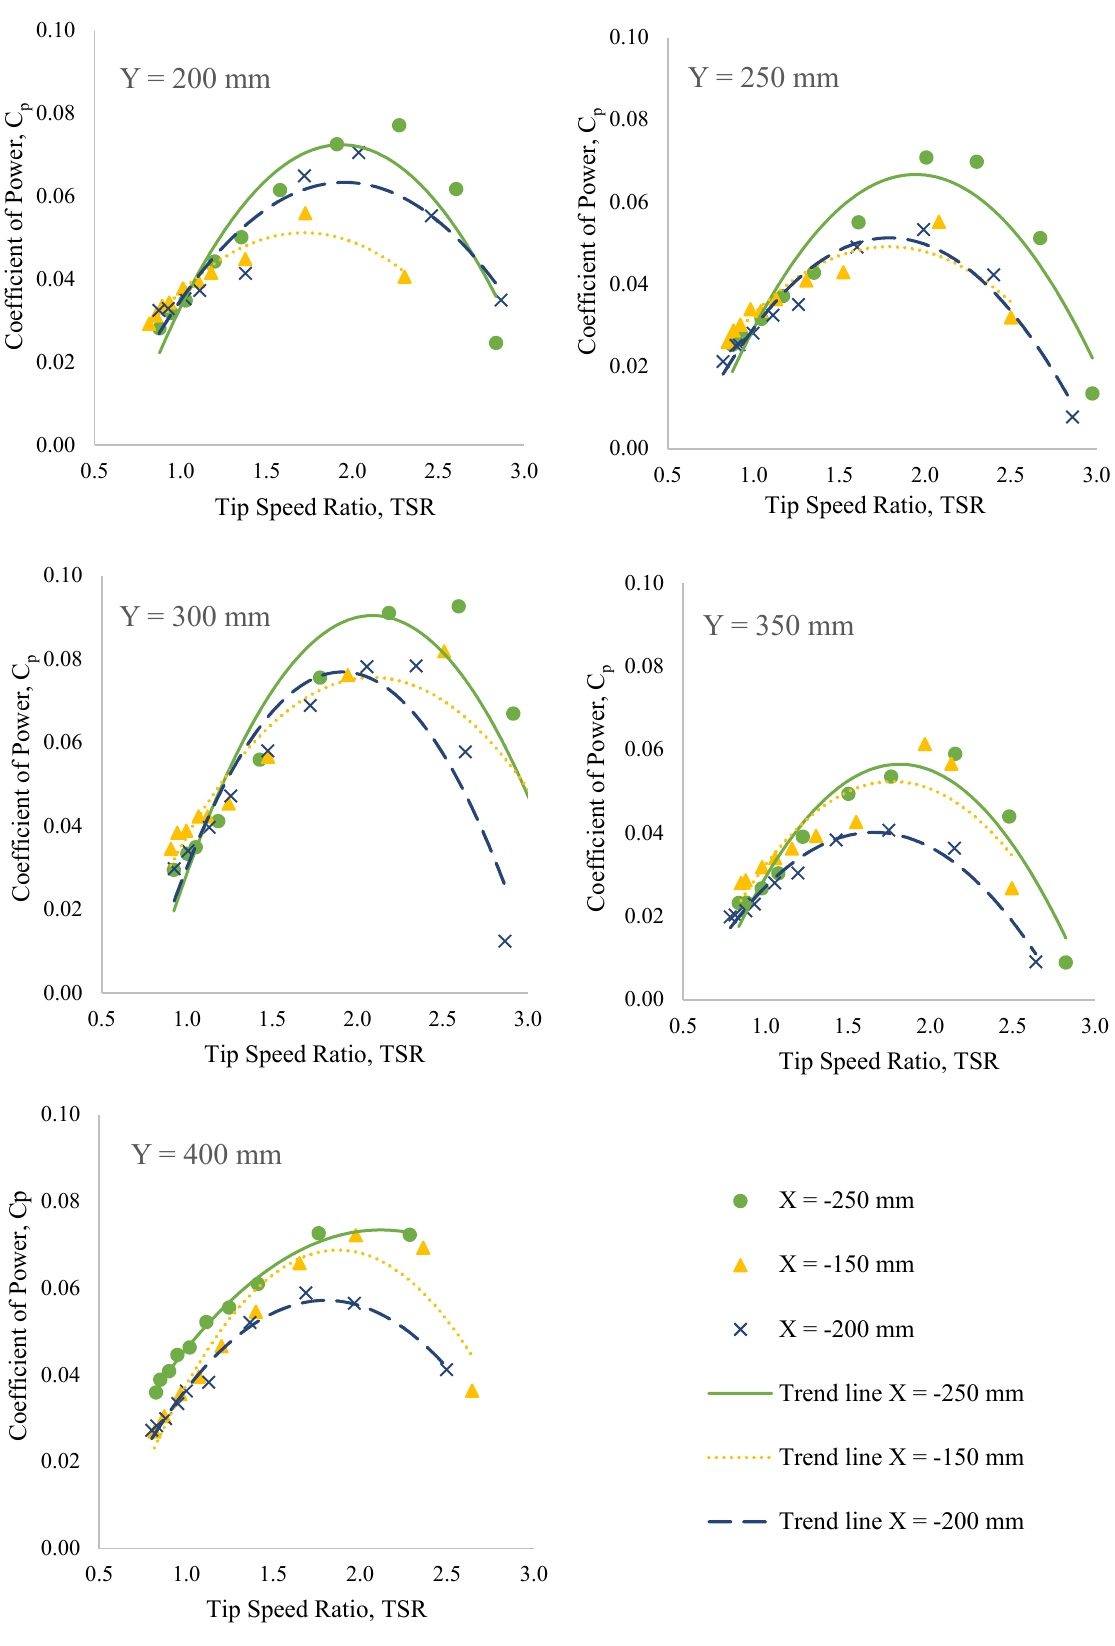
Figure 11. Coefficient of power against tip speed ratio for X = − 150 mm, − 200 mm, and − 250 mm at all vertical wind turbine